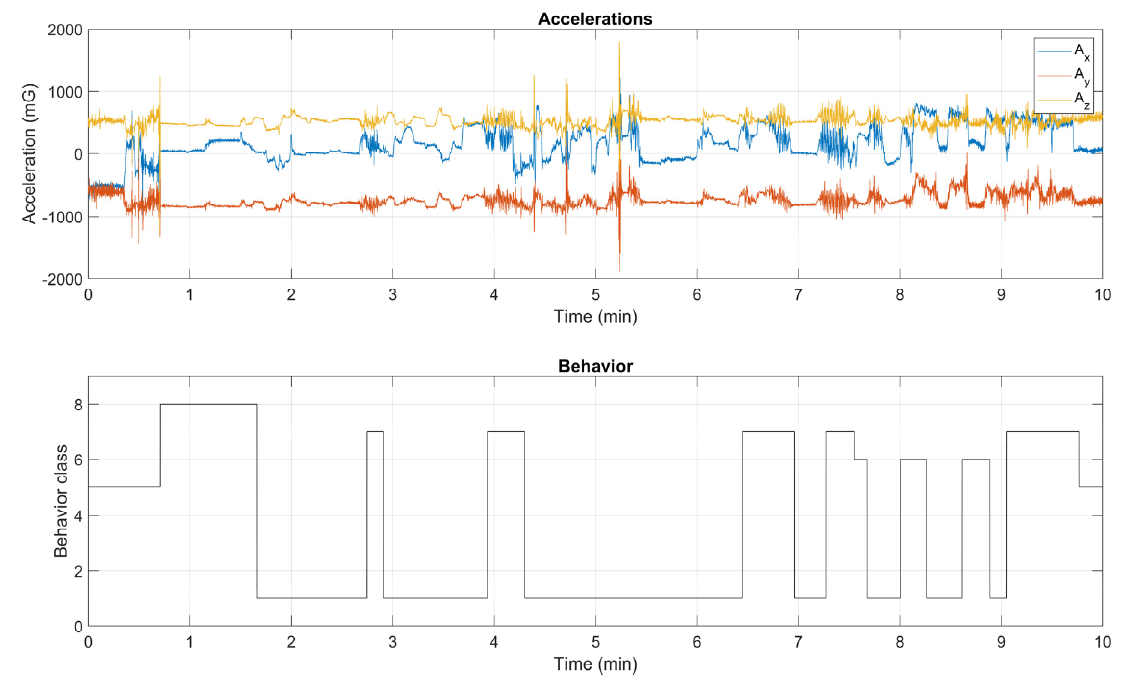
Figure 6. Example of the collected data. Accelerations on the three axes ( top ) and encoded observed behavior ( bottom ).